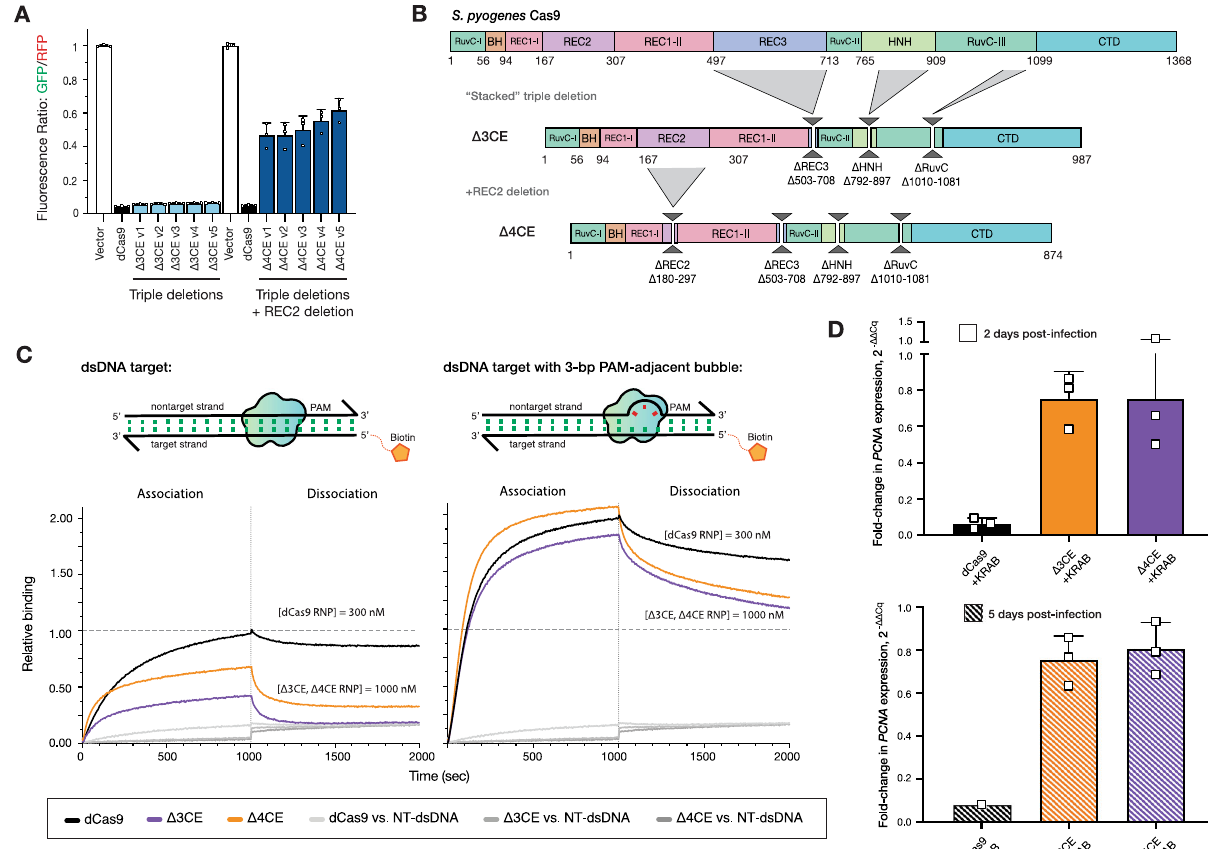
Fig. 3 Stacking multiple domain deletions on Cas9 results in defective DNA-binding activity. A In vivo transcription repression activity of MISER CRISPR effectors containing triple ( Δ 3CE) and quadruple ( Δ 4CE) deletion variants. Sublibraries of REC2, REC3, HNH, and RuvC were combined to build a library